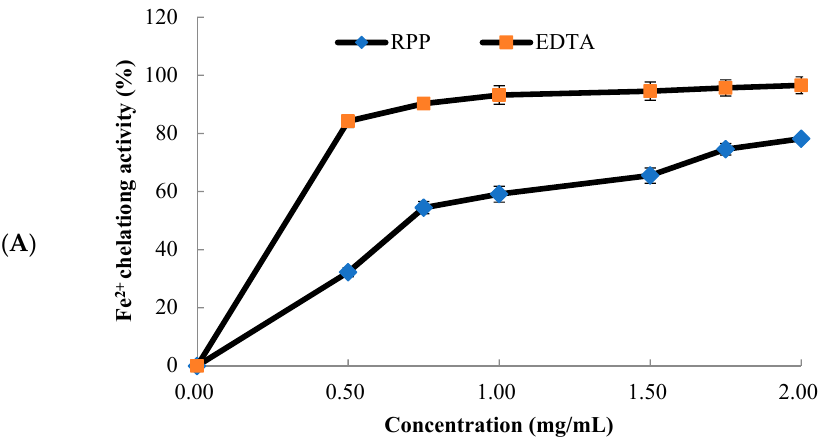
Figure 2. Iron- ( A ) and copper- ( B ) chelating activities of RPP with positive control of ethylene diamine tetraacetic acid (EDTA). Values represent the mean ± standard error of three determinations.